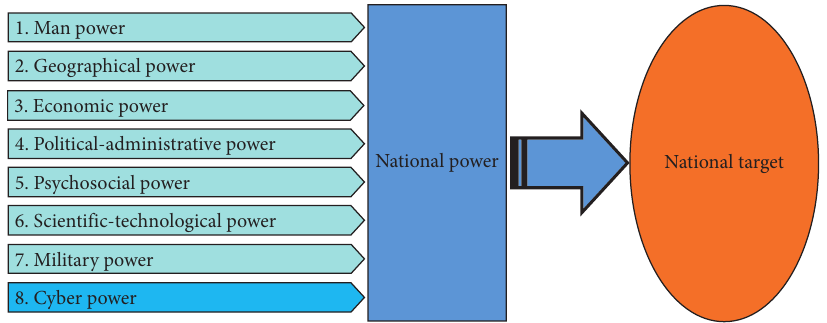
Figure 4: National power elements. Table 3: Evaluation of countries’ cyber power and capabilities